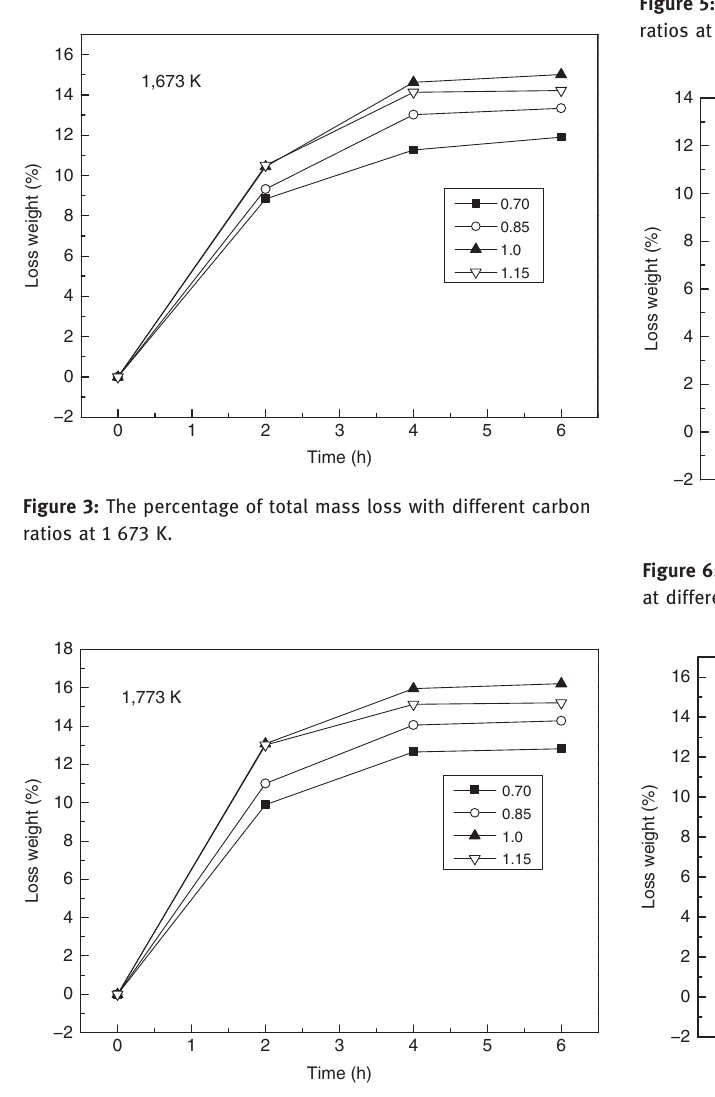
Figure 4: The percentage of total mass loss with different carbon ratios at 1,773 K.